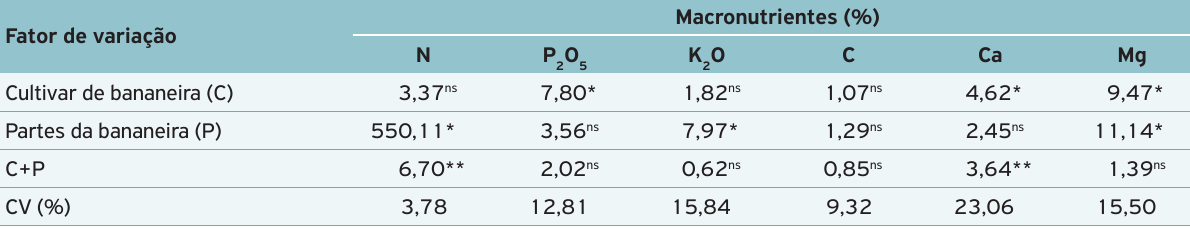
Tabela 3. Valores F obtidos na análise de variância de macronutrientes nos subtratos iniciais à base de resíduos (pseudocaule, folha